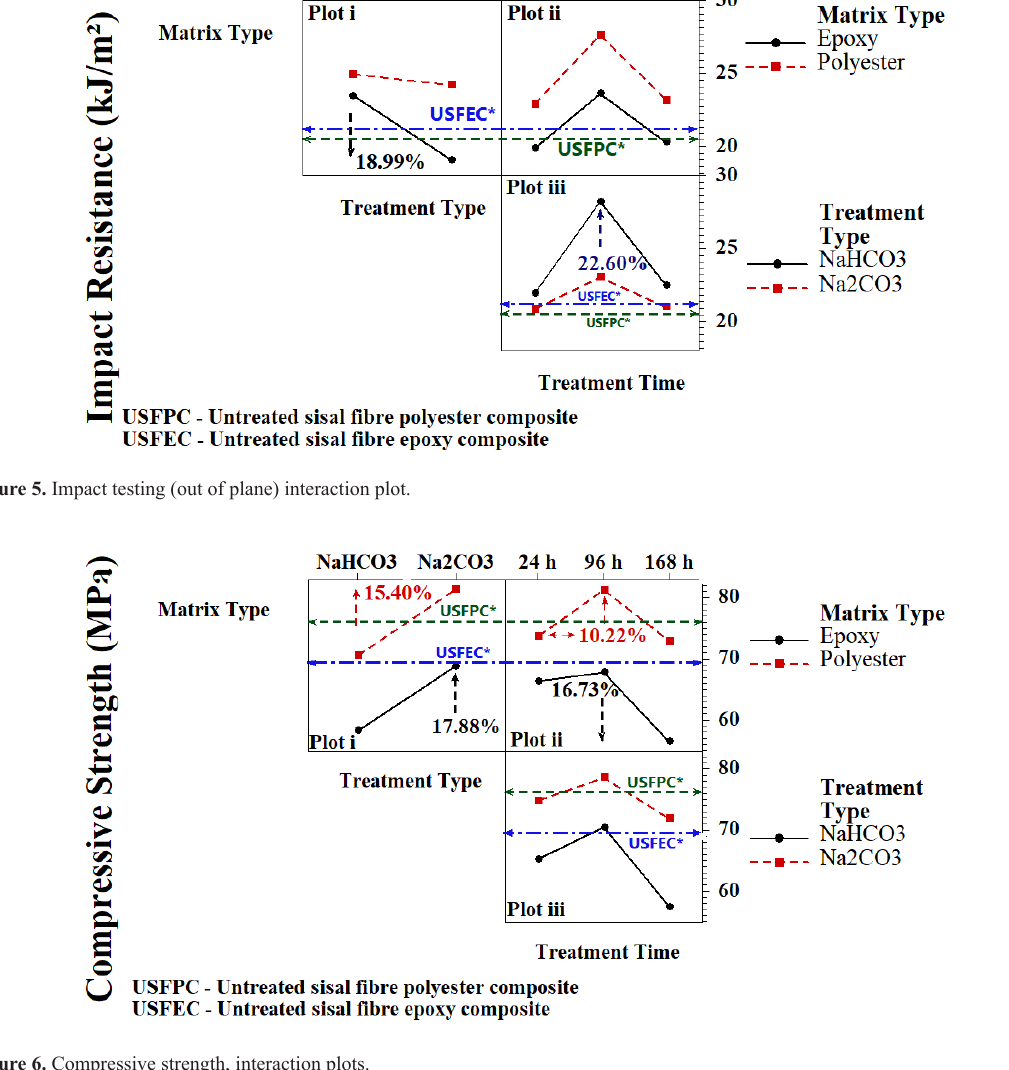
Figure 6. Compressive strength, interaction